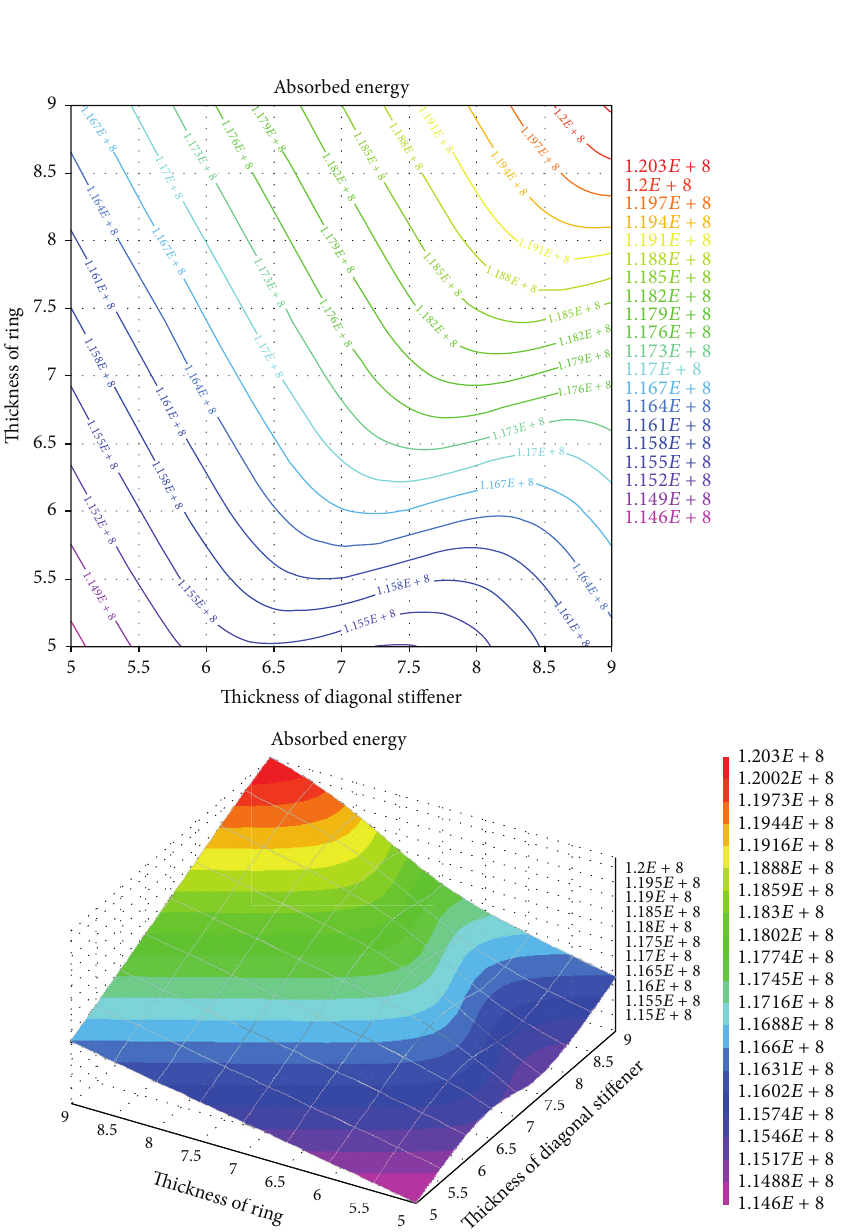
Figure 7: Obtained absorbed energy according to the thickness of ring and thickness of stiffener when the location of opening is down and thickness of plate is